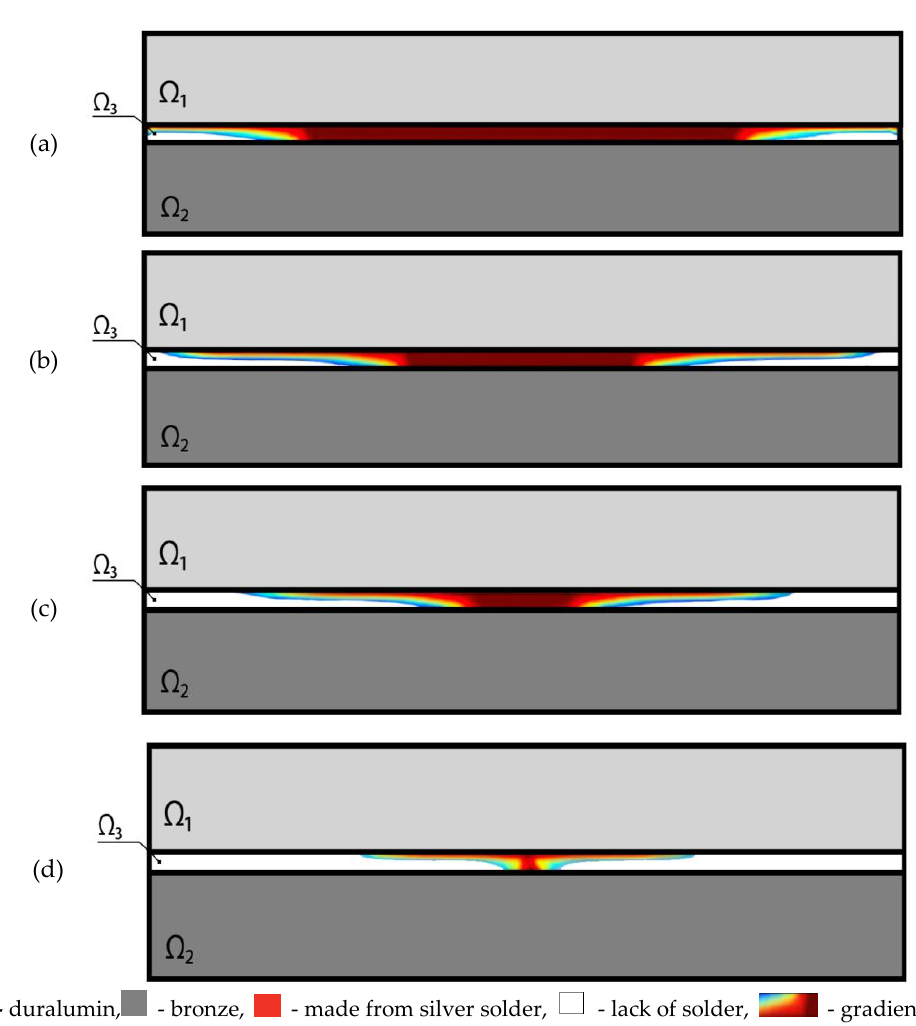
Figure 4. Topology of the optimal solder structure for symmetric three-layer package. ( a ) γ = 0.8; ( b ) γ = 0.6; ( c ) γ = 0.4; ( d ) γ = 0.2.